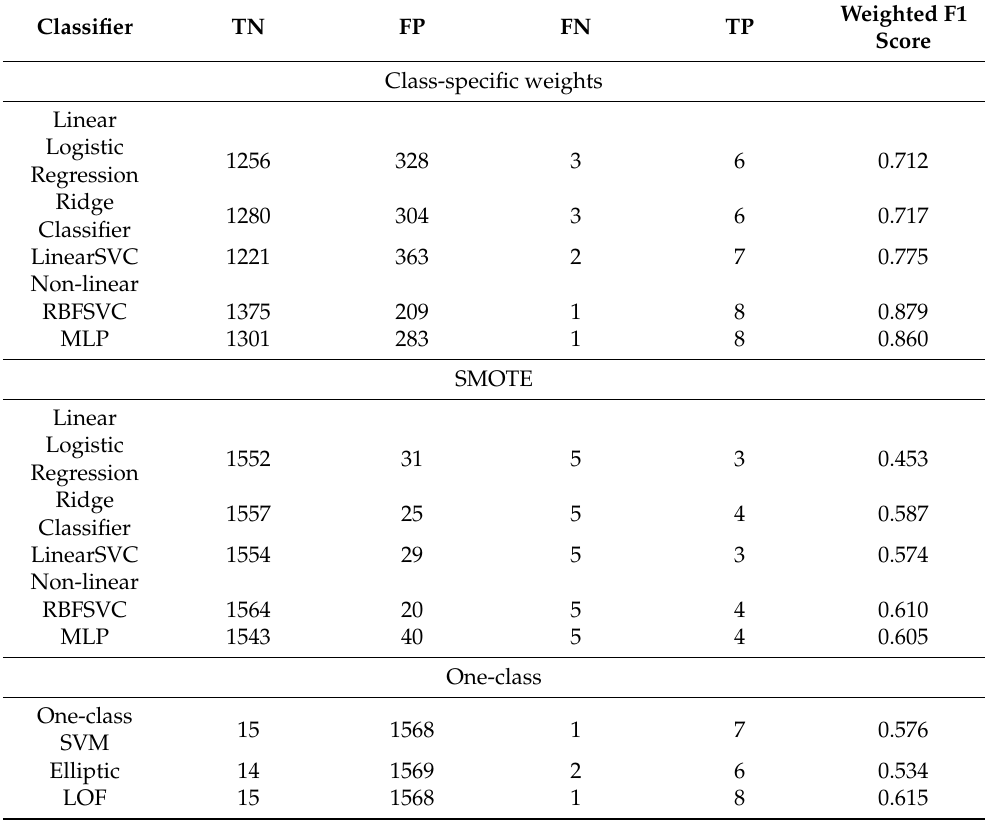
Table 4. Average classification performance for different models obtained across five different